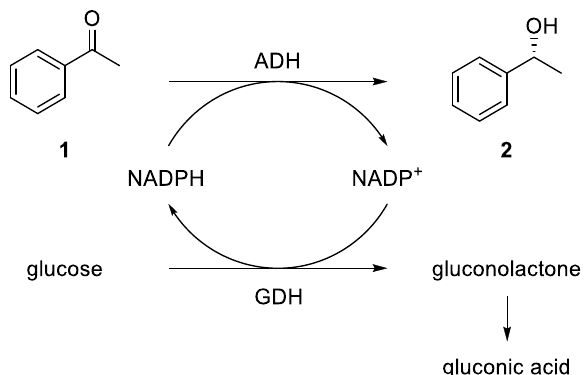
Figure 2. Alcohol dehydrogenase (ADH)-catalyzed reduction of acetophenone ( 1 ) to ( R )-1- phenylethanol (( R )- 2 ) using a glucose dehydrogenase (GDH)-based cofactor regeneration